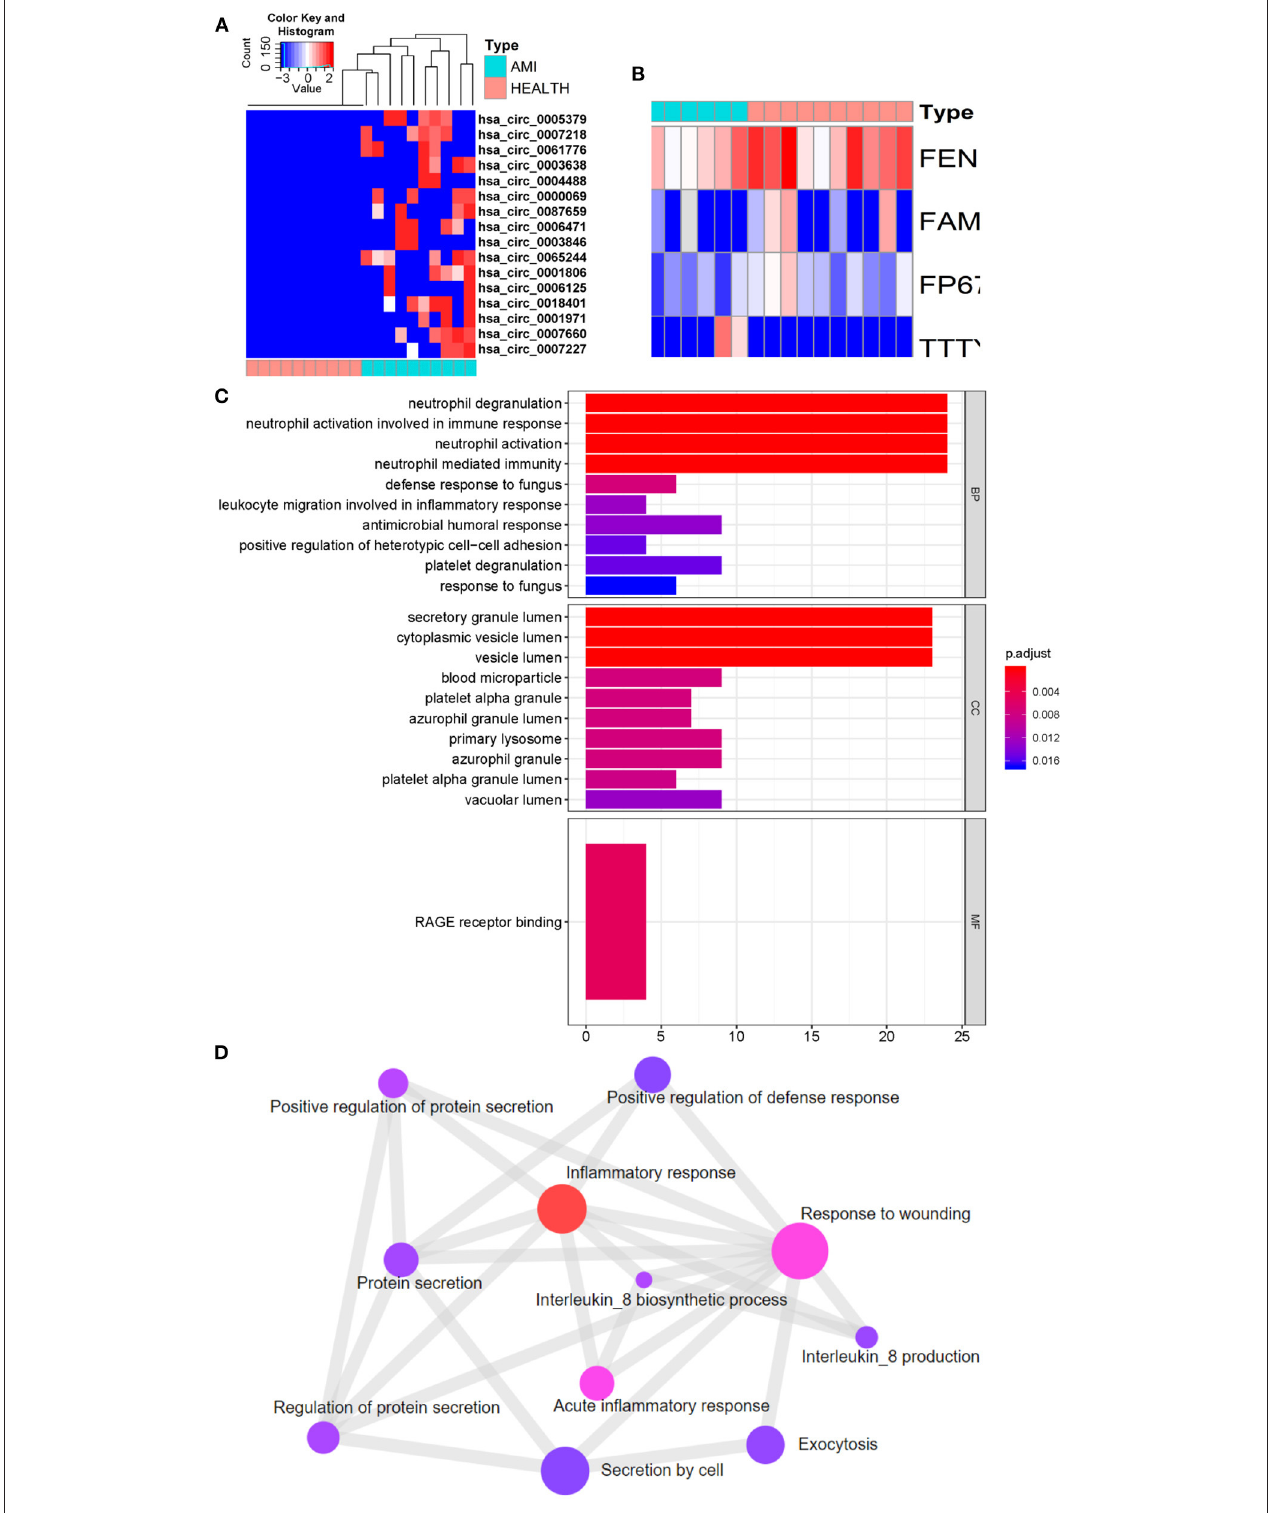
FIGURE 3 | Identification of different exosomal long RNAs and functional enrichment analysis between the AMI and the control. (A) Heatmap of significantly circRNA between AMI and control. (B) Heatmap of significantly lncRNA between AMI and control. (C,D) Functional enrichment analysis of significantly different exosomal